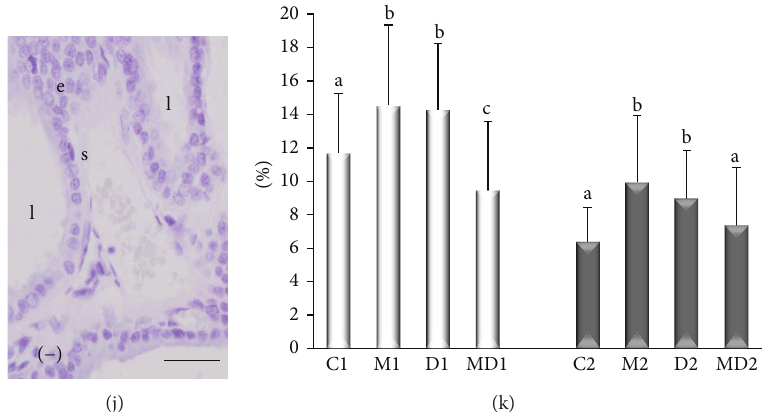
Figure 5: Tissue localization of melatonin receptor type 1B (MTR1B) in the ventral prostate of rats. (a) Short-term control (C1); (b) short-term control treated with MLT (M1); (c) short-term untreated diabetic (D1); (d) short-term diabetic treated with MLT (MD1); (e) long-term control (C2); (f) long-term control treated with MLT (M2); (g) long-term untreated diabetic (D2); (h) long-term diabetic treated with MLT (MD2). (i) Negative control; (j) positive control, brain tissue section of rat. (k) Relative frequency (%) for MTR1B-positive areas. e: epithelium; l: lumen; s: stroma. Magnification: 400x, bar = 25 𝜇 m. Light bars: short-term experiment and dark bars: long-term experiment ( 𝑁 = 5 animals/group). Different lowercase letters indicate significant differences between experimental groups C1, M1, D1, and MD1 (nonparametric data), and